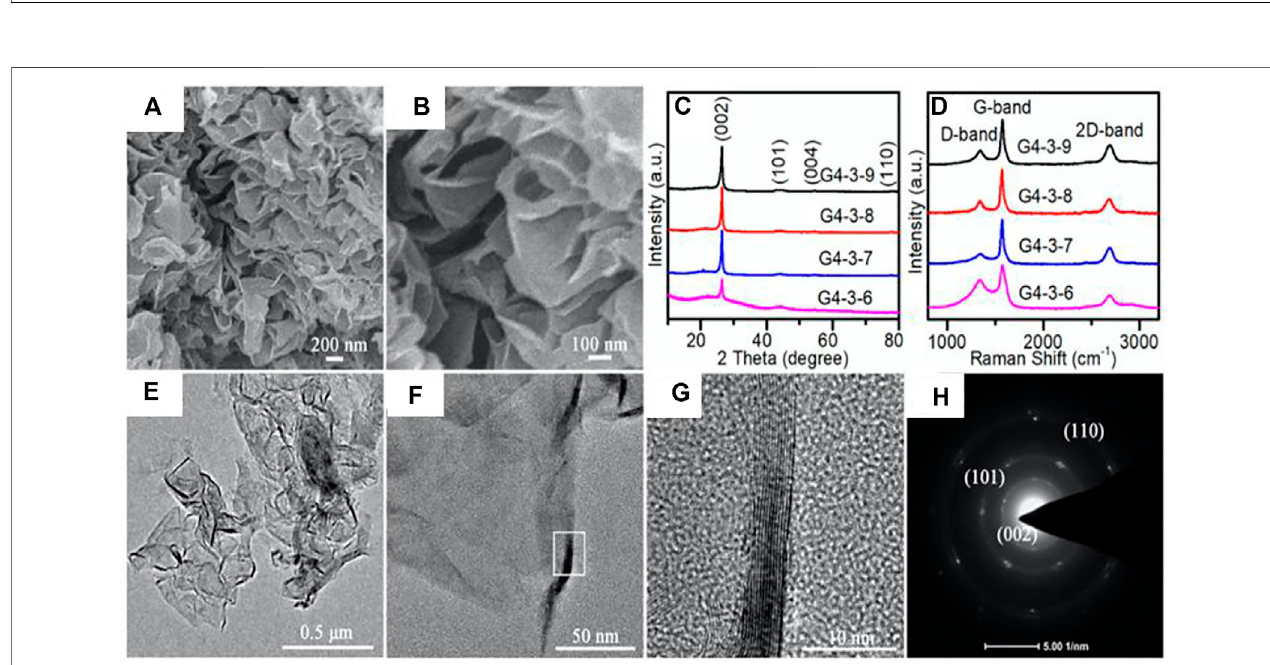
FIGURE 12 | (A,B) Field emission scanning electron microscopy (FESEM) images of the as-synthesized G4-3-9. (C) XRD patterns and (D) Raman spectra of the as-synthesized samples at different carbonizationtemperatures. (E,F) TEM images, (G) high-resolution TEM (HRTEM),and (H) selected areaelectron diffraction (SAED) pattern of the sheets (G4-3-9). Graphene sheets prepared using pre-cross-linked samples after 4 h, and 3 g of FeCl 3 at 900 ° C is labeled as G4-3-9. The fi gure is reprinted with permission from Hu et al., 2020b, Copyright 2020, American Chemical Society.